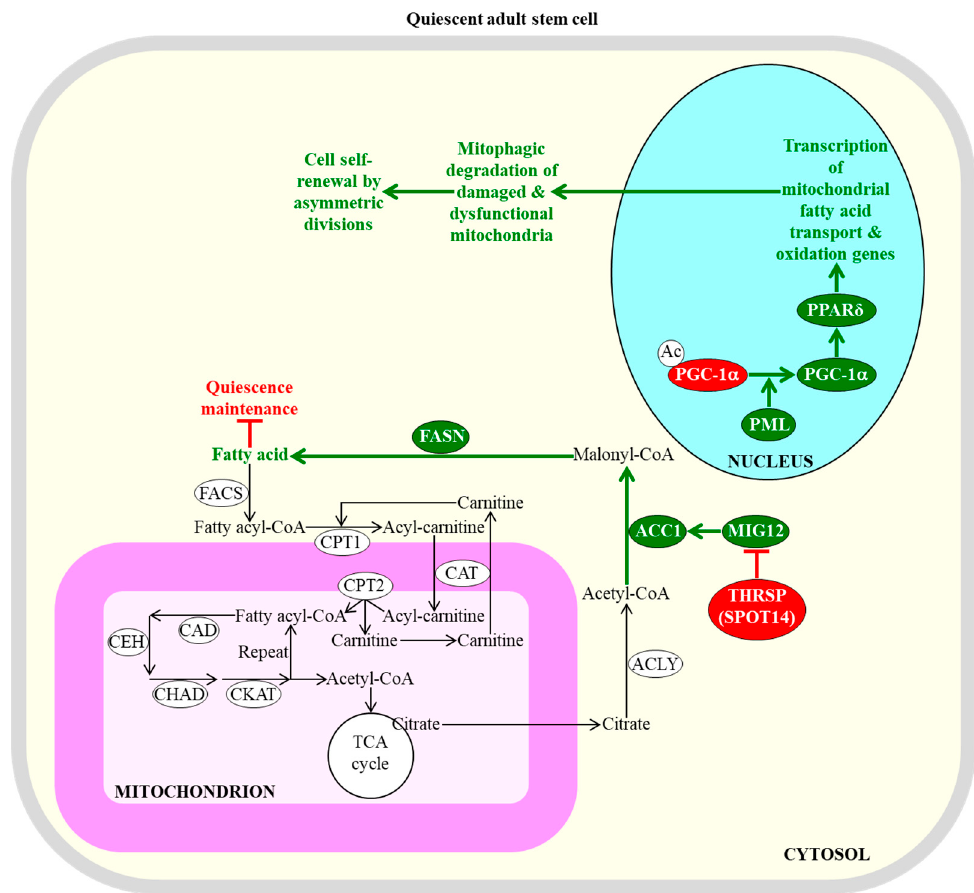
Figure 2. Mitochondrial β -oxidation of fatty acids and their synthesis in the cytosol of adult stem cells control the efficiency with which these cells can sustain quiescence or self-renew by asymmetric divisions. An inhibition of fatty acid synthesis in the cytosol is needed to sustain the quiescent state of adult neural stem cells. An activation of the transcription of nuclear genes that are involved in mitochondrial fatty acid transport and β -oxidation within adult stem cells is essential for the self-renewal of these cells by asymmetric divisions; such divisions lead to the formation of a new quiescent stem cell and an actively dividing daughter progenitor cell. Enzymes, metabolites, and processes whose activities, concentrations, and rates must be increased to maintain the quiescence of adult stem cells are displayed in red. Enzymes, metabolites, and processes whose activities, concentrations, and rates need be decreased to promote the self-renewal of adult stem cells by asymmetric divisions are displayed in green. The back arrows define chemical reactions whose rates are not essential for the maintenance of quiescence by adult stem cells. The green arrows define chemical reactions or processes whose rates or intensities must be decreased to maintain the quiescence of adult stem cells. The red inhibitory bars define inhibitory effects whose intensities must be increased to maintain the quiescence of adult stem cells. See text for more details. Abbreviations: Ac, acetyl group; ACC1, acetyl-CoA carboxylase 1; ACLY, ATP citrate lyase; CAD, acyl-CoA dehydrogenase; CAT, carnitine acylcarnitine translocase; CEH, enoyl-CoA hydratase; CHAD, hydroxyacyl-CoA dehydrogenase; CKAT, ketothiolase; CPT1 and CPT2, carnitine palmitoyltransferases 1 and 2 (respectively); FACS, fatty acyl-CoA synthase; FASN, fatty acid synthase; MIG12, midline-1-interacting G12-like protein; PGC-1 α , peroxisome proliferator-activated receptor-gamma coactivator 1 α ; PML, promyelocytic leukaemia protein; PPAR δ , peroxisome proliferator-activating receptor type δ ; SPOT14, the 14th spot of proteins; THRSP, thyroid hormone-inducible hepatic protein.